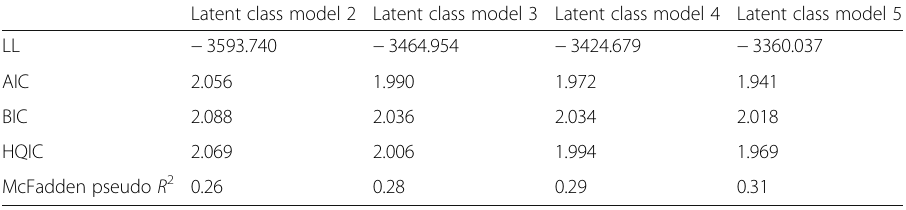
Table 5 Latent class model